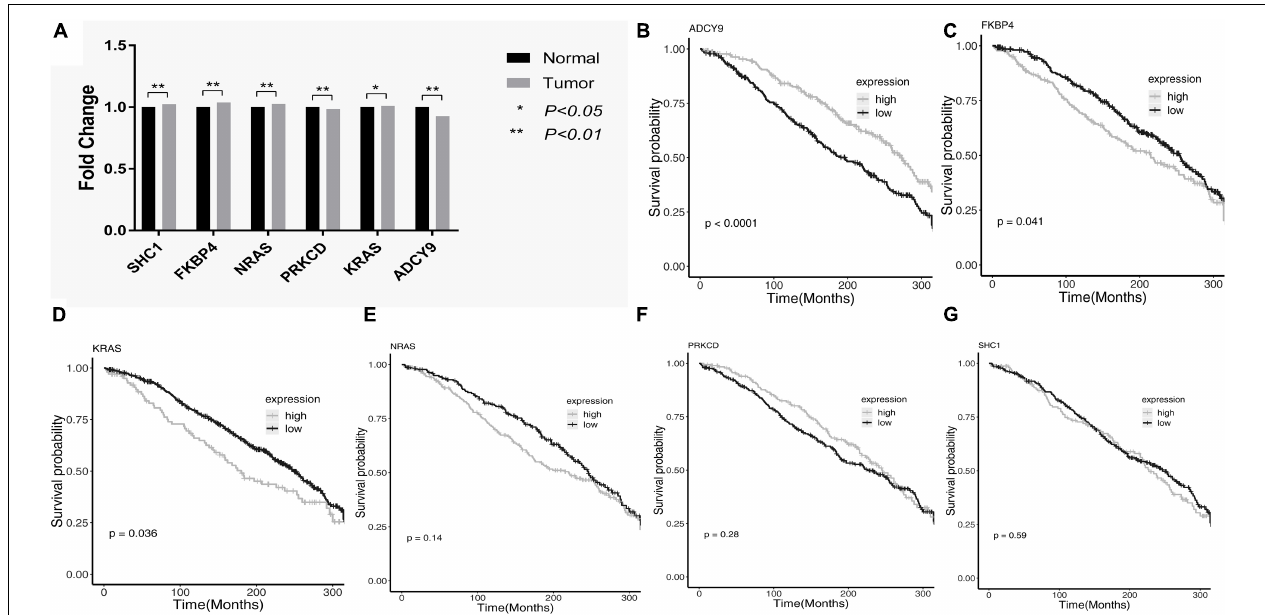
FIGURE 3 | The relative expression and survival curves of these genes. (A) The bar graph showed the relative expression of PRKCD, ADCY9, SHC1, FKBP4, NRAS and KRAS among tumor tissues and normal tissues in the GSE63459. (B–D) The high expressions of FKBP4 and KRAS reduced the survival time of LUAD patients and the high expressions of ADCY9 prolonged the survival time of LUAD patients in the GSE68465. (E–G) In the GSE68465, SHC1 , NRAS and PRKCD were not associated with the prognosis of